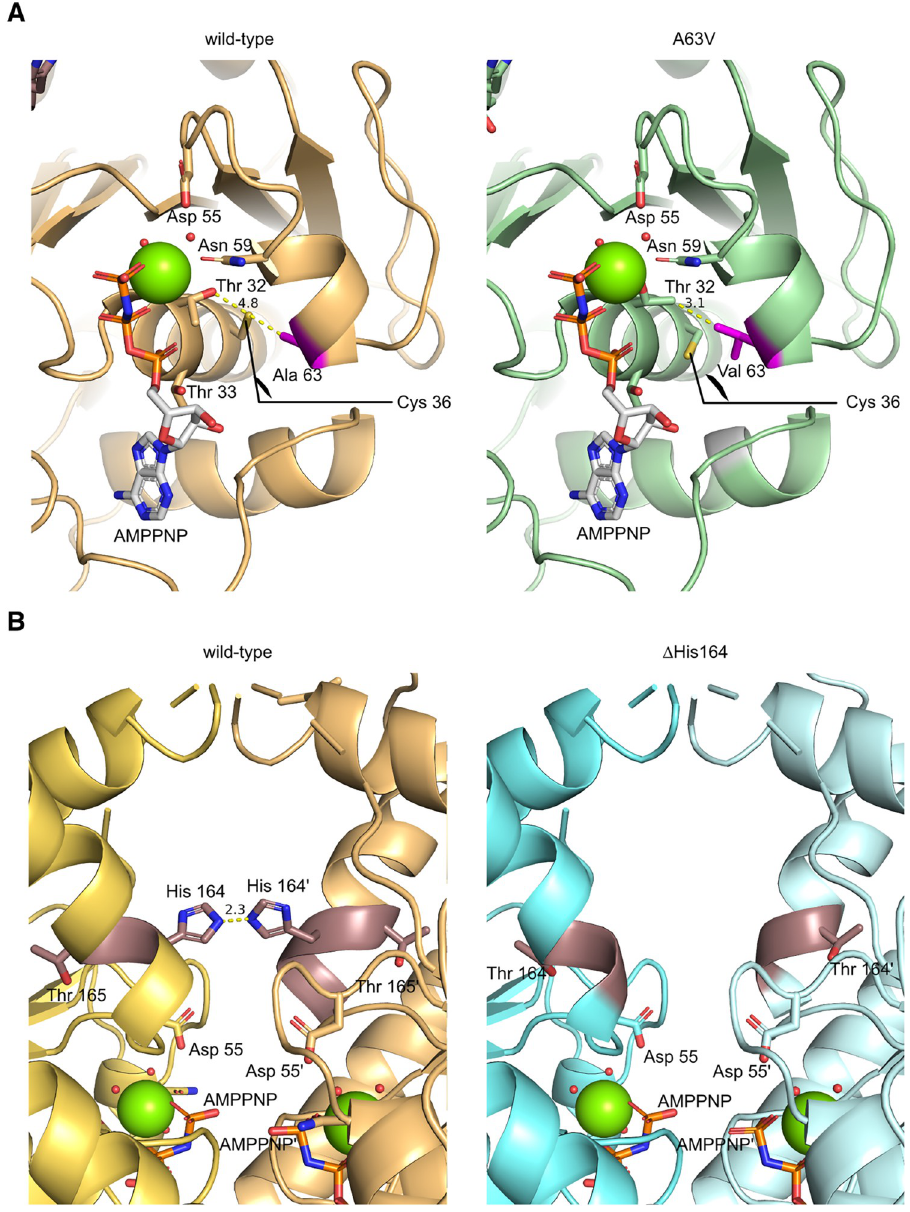
Fig 7. Structural representation of the effect of the A63V and Δ H164 mutations in the ATP-bound ASNA-1 dimer complex. The in-silico models of C . elegans ASNA-1 mutants show the structural impact of these mutations in the key processes of ASNA-1 ATPase activity and the dimer complex formation. (A) In the left panel, the model of an ASNA-1 wild-type protein monomer in complex with Mg (green) and AMPPNP (white) is shown in light orange. The amino acid Ala63 is shown in pink. The amino acids depicted show the influence of the amino acid at position 63 on the amino acids coordinating the Mg atom. In the right panel, the monomer of ASNA-1(A63V) is represented in green and the Val63 in pink. The distances between the amino acid at position 63 and Thr32 are shown in yellow. (B) In the left panel each monomer of the ASNA-1 wild-type dimer in complex with Mg (green) and AMPPNP in light orange and yellow-orange is represented by, in deep salmon is shown the position of His164. The distance between the His164 of each monomer is displayed in yellow. In the right panel, each monomer of ASNA-1( Δ His164) is colored in cyan and light cyan, and the amino acid Thr164 is colored in dark